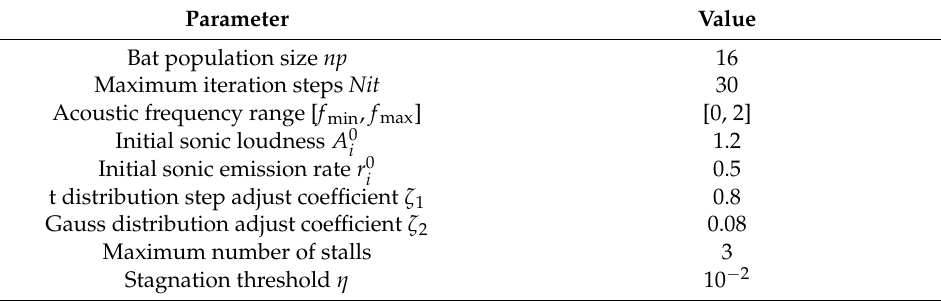
Table 4. Basic parameter settings of the modified bat